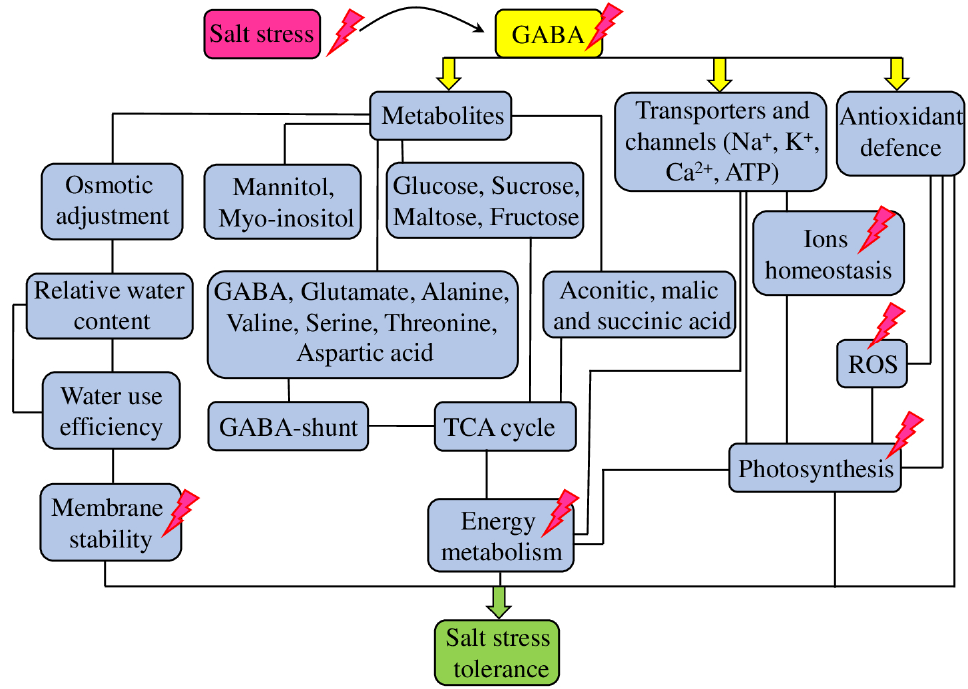
Figure 6. Different metabolites and signaling pathways activated by GABA to mitigate salt stress in plants (yellow arrows). The primary targets of salt stress are represented by magenta lightning.